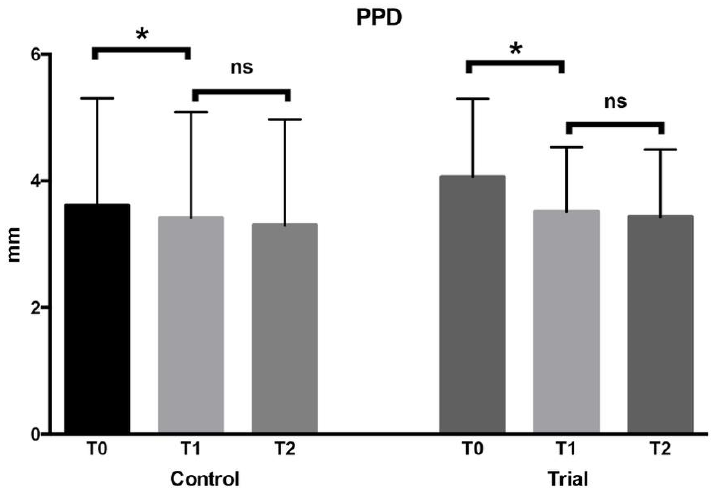
Figure 6. PPD values among the time frames of the study. * = p < 0.05. ns = not